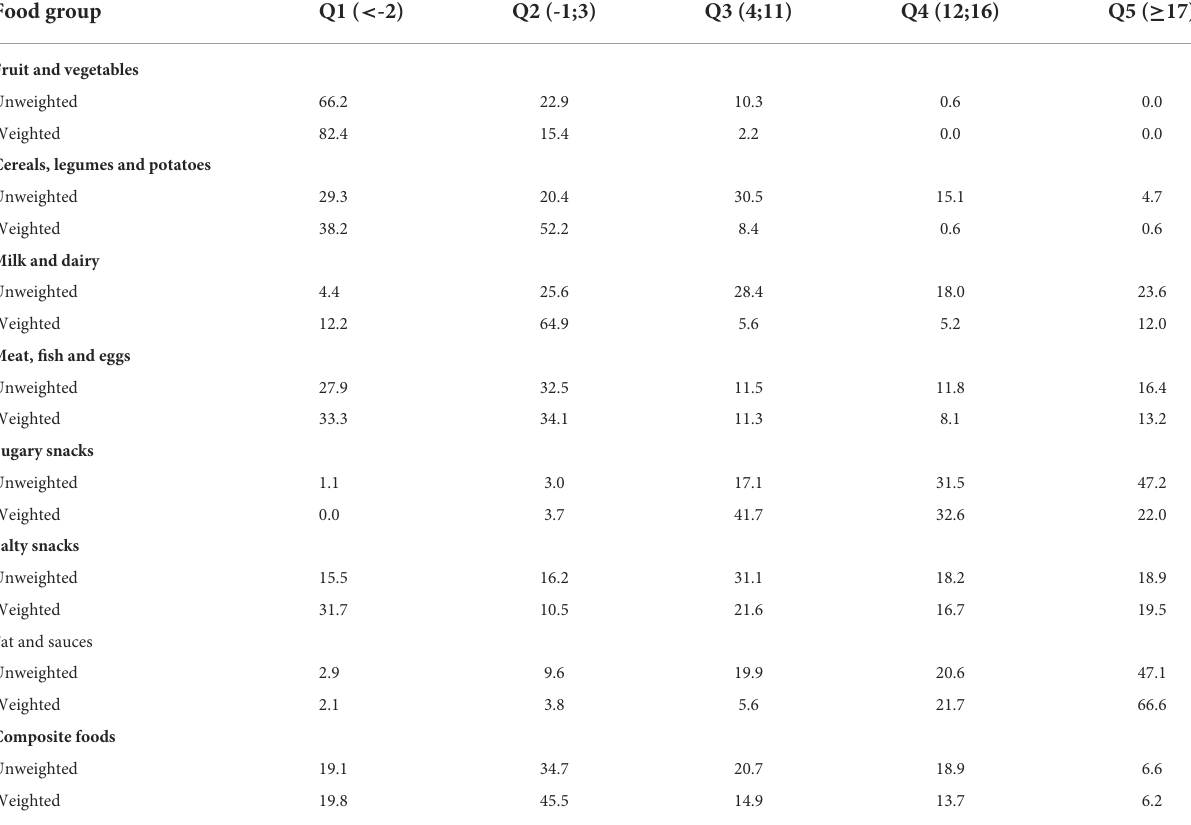
TABLE 1 Comparison of non-weighted and weighted analysis as presented in Julia et al. (19): distribution (%) a of food groups across quintiles of FSA-score distribution in the French NutriNet Santé food composition database (non-weighted n = 3,331; weighted n = 1,878). Food